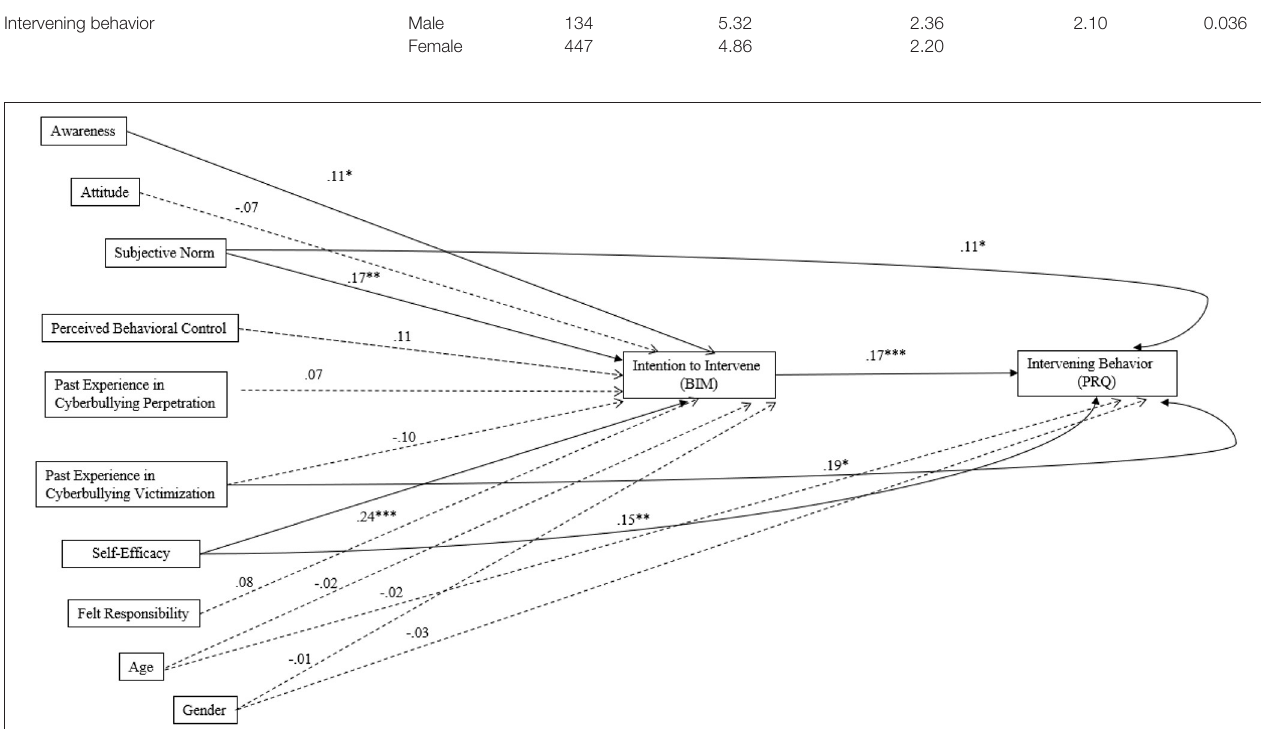
FIGURE 2 | Results of path analysis among variables. Values in path analysis represent standardized regression coefficients. Solid lines and dotted lines represent significant paths and non-significant paths, respectively. * p < 0.05, ** p < 0.01,*** p <